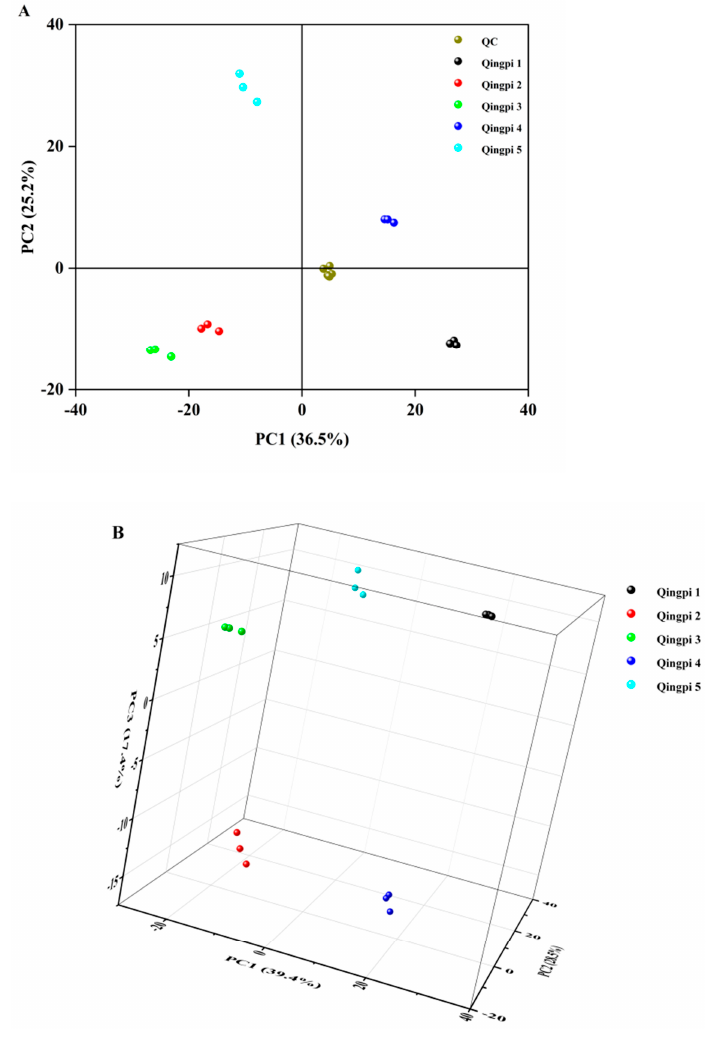
Figure 5. Multivariate analysis of LC-MS − based metabolomics data of Qingpi 1, Qingpi 2, Qingpi 3, Qingpi 4, and Qingpi 5 samples stored for 1, 2, 3, 4, and 5 years, respectively. Two − dimensional score plots of principle component analysis (PCA) with QC samples ( A ). Three-dimensional score plots of PCA without QC samples ( B